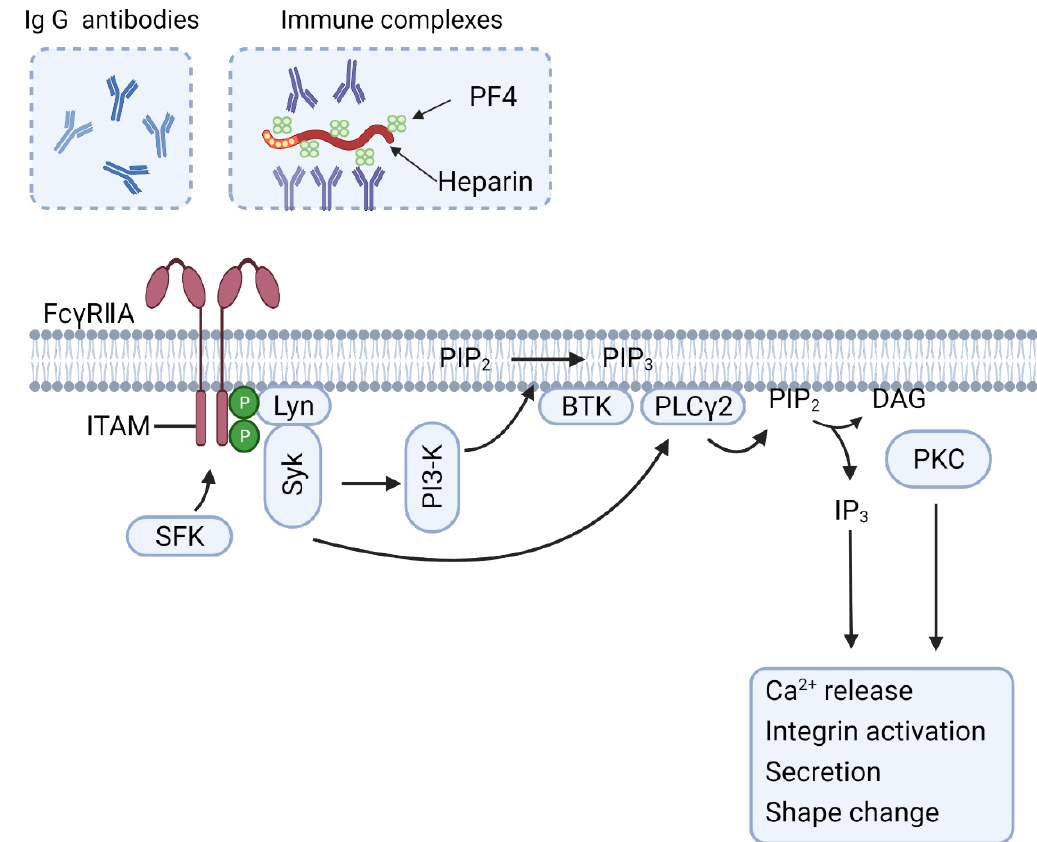
Figure 3. Fc γ RIIA-induced platelet activation and signaling pathways. IgG antibodies or larger immune complexes can activate platelets by dimerization or clustering of Fc γ RIIA receptors. The tyrosine-based activation motif (ITAM) is then phosphorylated by Src-family kinases (SFK), recruiting and phosphorylating the tyrosine kinase Syk, which in turn activates phosphoinositide 3-kinase (PI3K). The production of phosphatidylinositol-3,4,5-trisphosphate (PIP 3 ) recruits Bruton’s tyrosine kinase (BTK) and phospholipase C γ (PLC γ ), which leads to activation of downstream responses via IP 3 production and protein kinase C (PKC). The extent of platelet activation is likely dependent on the type of IgG antibodies and immune complexes. Created with BioRender.com.